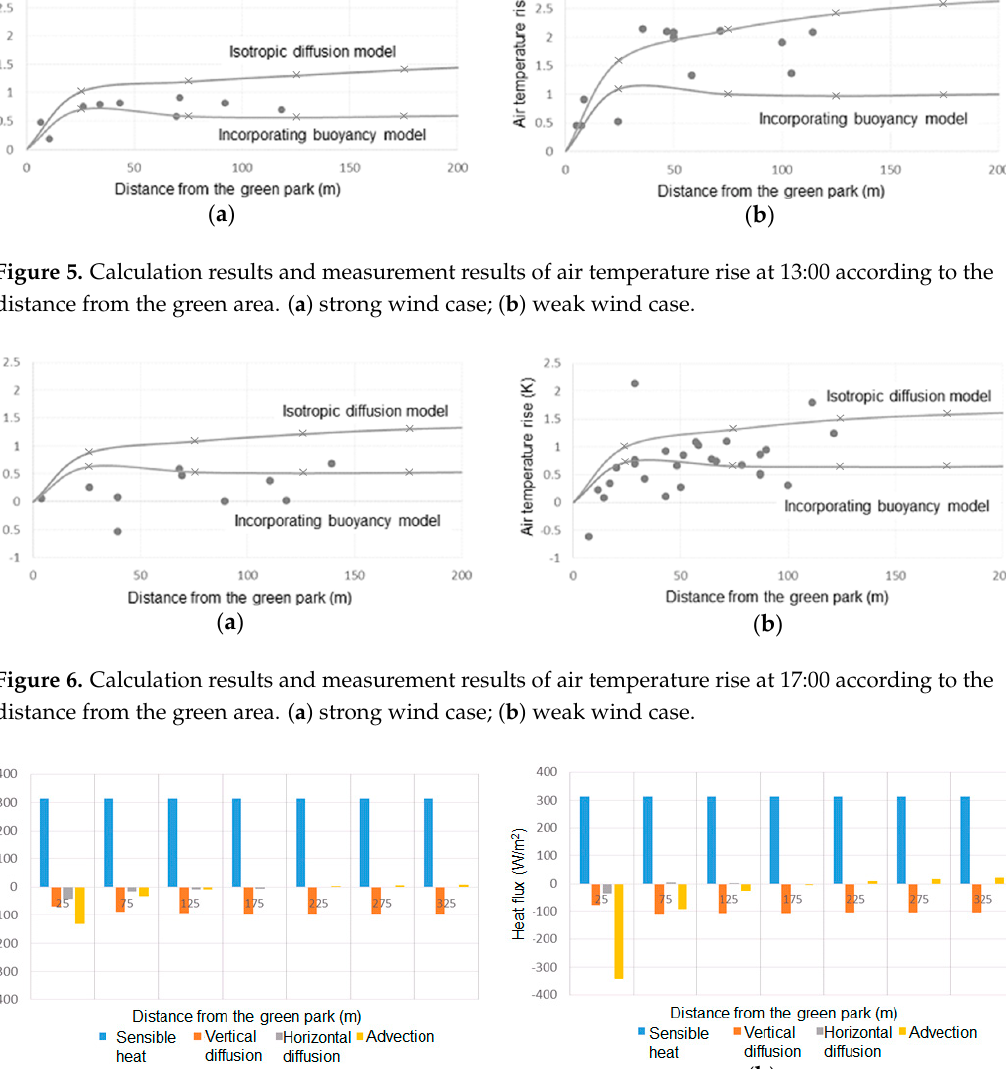
Figure 7. Distance from the green area and heat flux component of the calculation result at 13:00. ( a ) isotropic diffusion model; ( b ) incorporating buoyancy model.